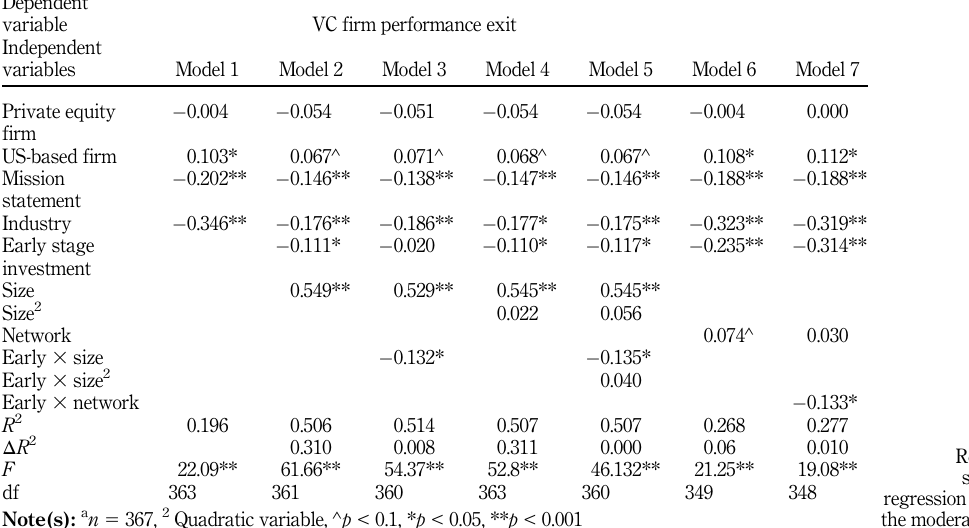
Table 4. Results of the standardized regression analysis